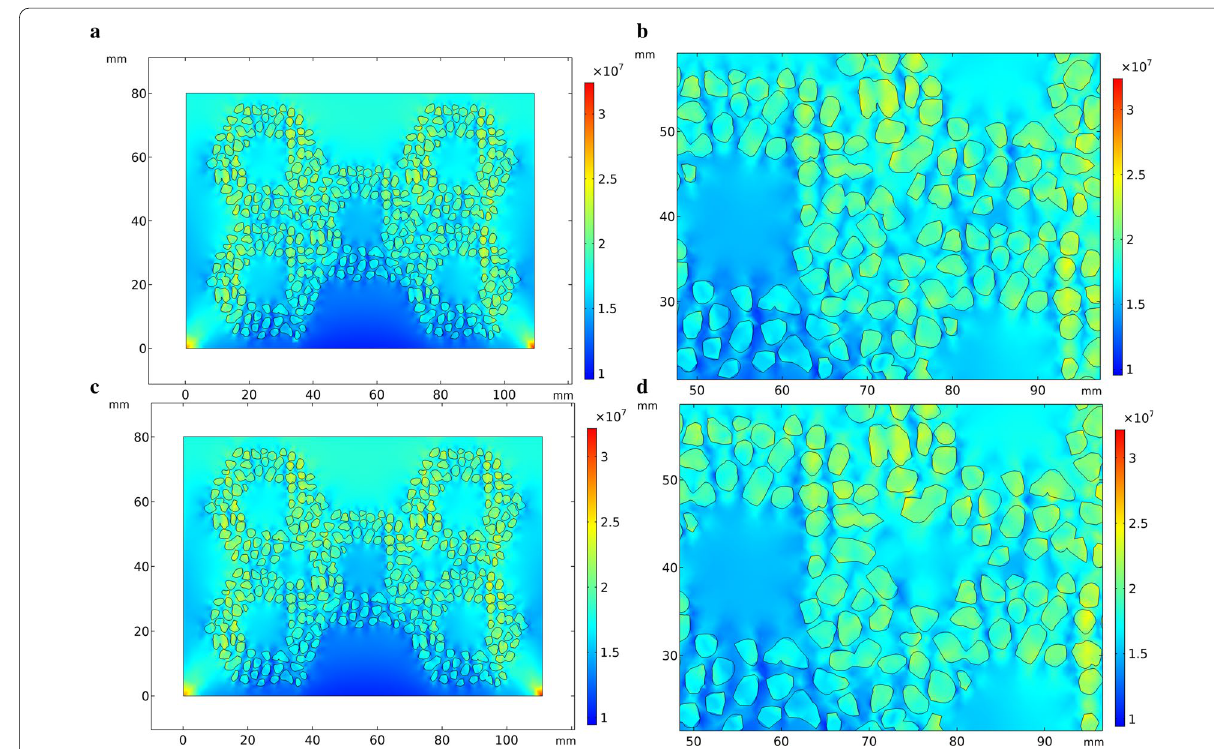
Fig. 7 Compressive stress in the optimized model. a Initial perform, b partial enlarged view of the optimized perform, c preform with circular holes added, d partial enlarged view of the perform with circular holes